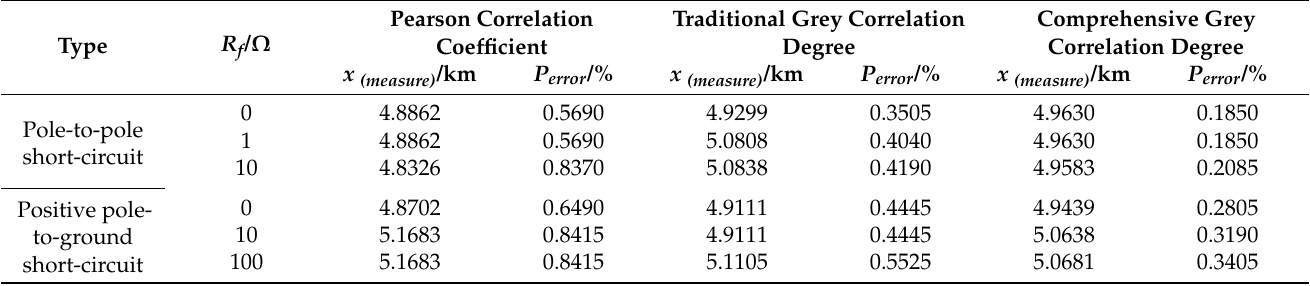
Figure 12. Simulation results for positive pole-to-ground short-circuit under three algorithms. Table 4. Fault location results for three similarity